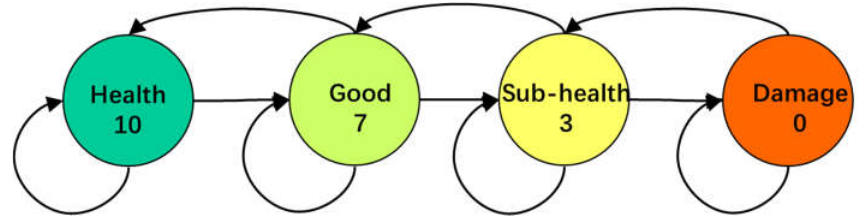
Figure 4. State transition process model.